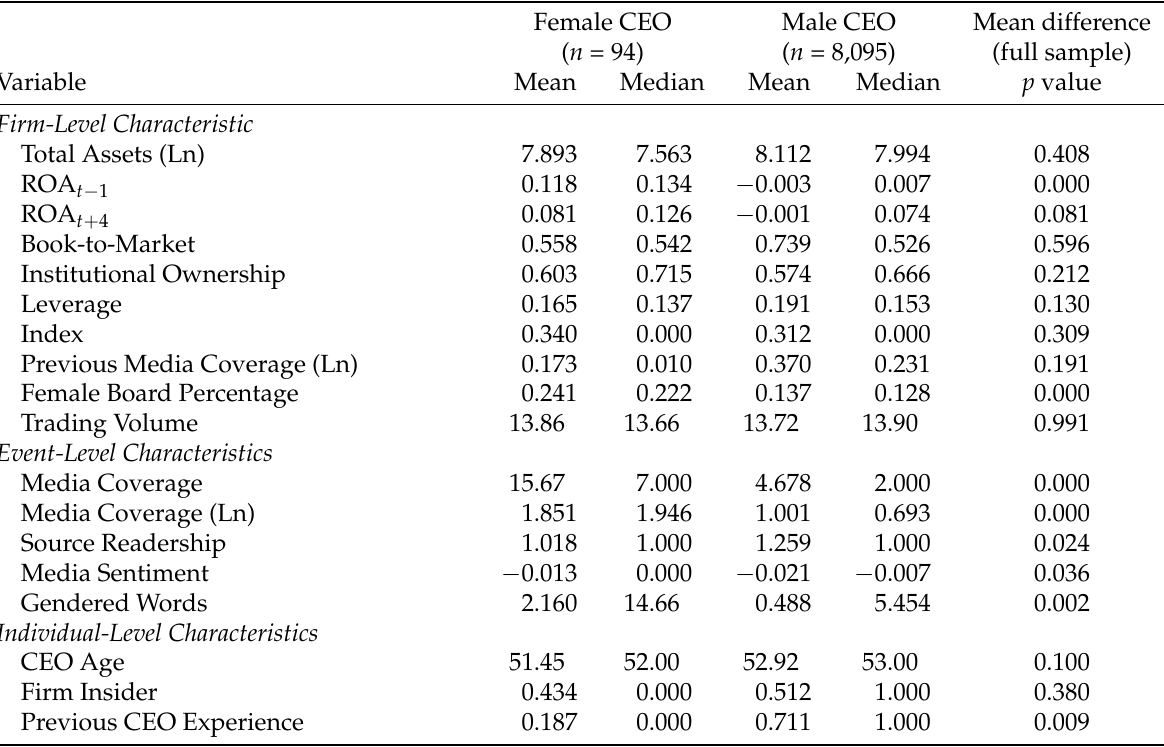
Table 3: Descriptive statistics, by gender